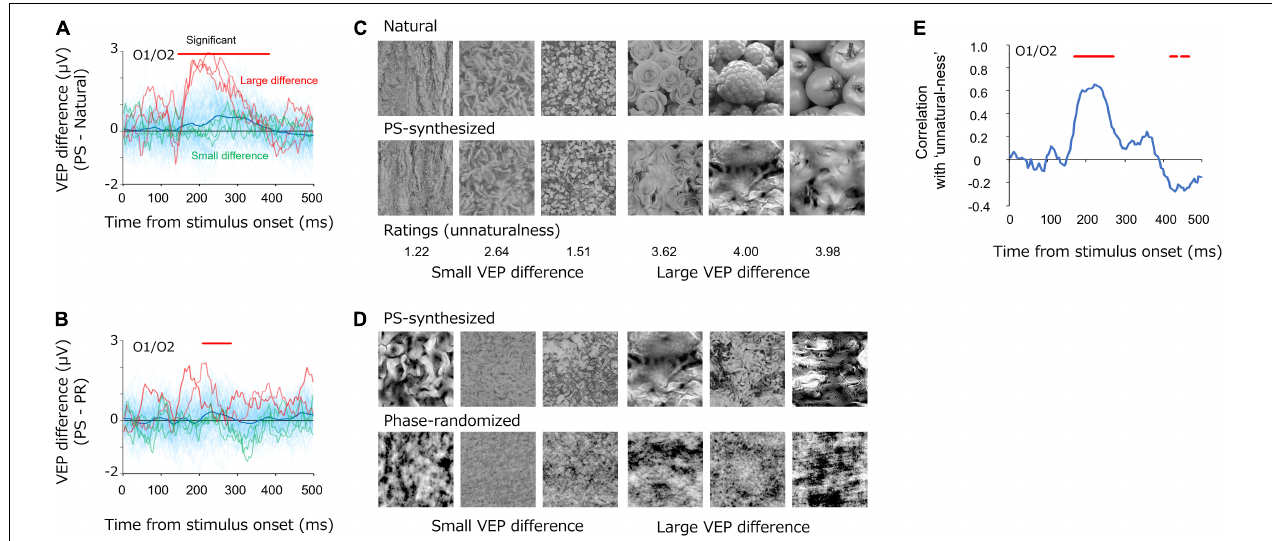
FIGURE 7 | (A,B) Differential VEPs at the occipital electrodes (O1/O2) between the PS-synthesized textures and natural textures (A) and between the PS-synthesized textures and phase-randomized textures (B) . The light-blue traces are the differential VEPs for each texture. The red traces show the three largest differential VEPs and the green traces show the three smallest differential VEPs. (C,D) Pairs of textures that elicited small (left three images) and large (right three images) differential VEPs. Numbers below the images in (C) represent the average “unnaturalness” rating of the PS-synthesized texture. (E) Correlations between the differential VEPs and the perceptual unnaturalness ratings. The red bars indicate the statistically significant periods ( p < 0.05, FDR-corrected).